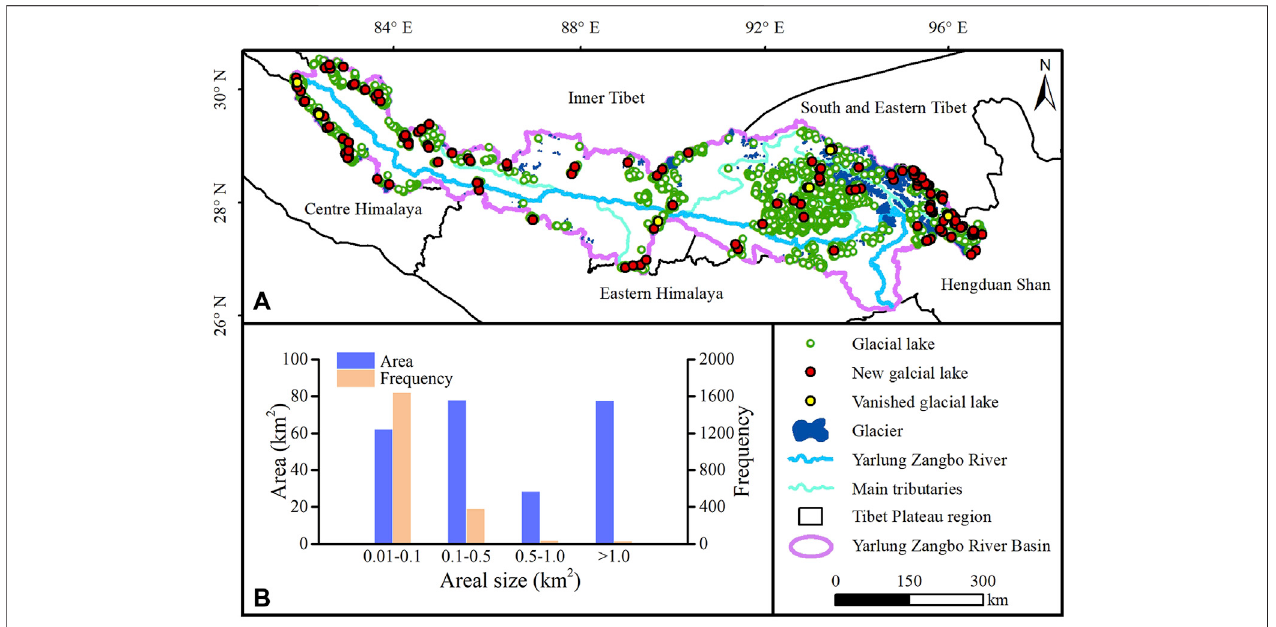
FIGURE5|(A) Distributionofglacial lakesinthe YZRB in2020(The new andvanishedglacial lakesare between1990and 2020); (B) frequencyand areaofglacial lakes of different sizes in 2020.